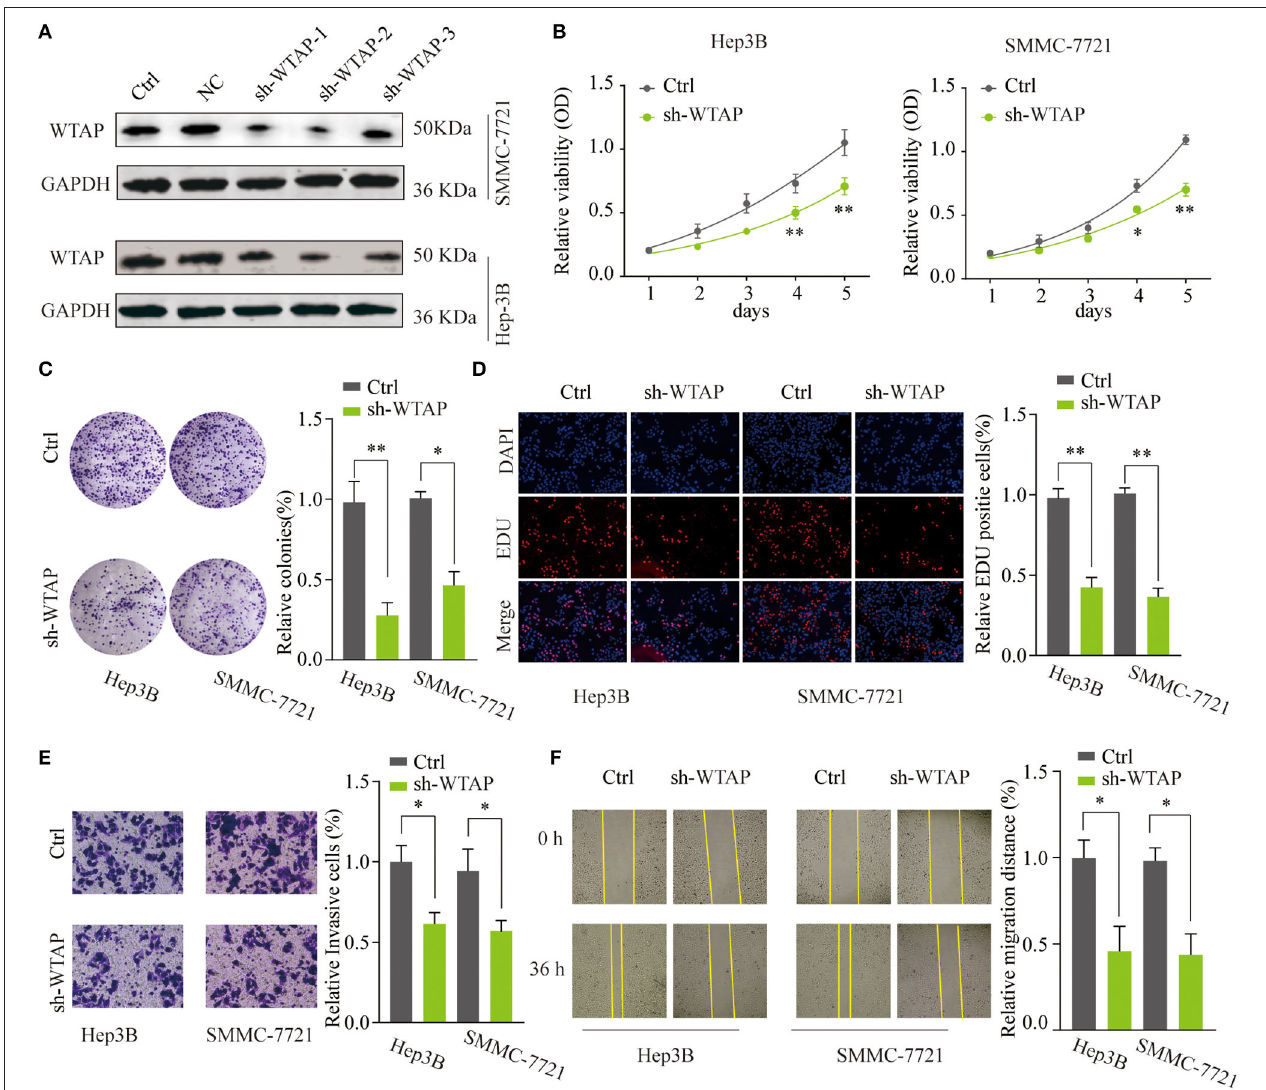
FIGURE 3 | Knockdown of WTAP inhibits the proliferation and invasion of in vitro HCC cells. (A) SMMC-7721 or Hep3B cells were transfected with different short hairpin RNA (shRNAs) targeting WTAP or control shRNA. WTAP protein expression was analyzed by a western blot 48h later. GAPDH was used as a loading control. Hep3B or SMMC-7721 cells were transfected with sh-WTAP or control shRNA. (B–D) Effects of the knockdown of WTAP on the cell proliferation were determined by a cell counting kit-8 (CCK-8) assay (B) , a colony formation assay (C) , and the 5-Ethynyl-2 ′ -deoxyuridine (EdU) staining assay (D) . Data were represented as the mean ± SD. (E,F) The invasion and migration abilities of HCC cells were assessed by using the Transwell invasion (E) and wound healing assays (F) . * p < 0.05, ** p <